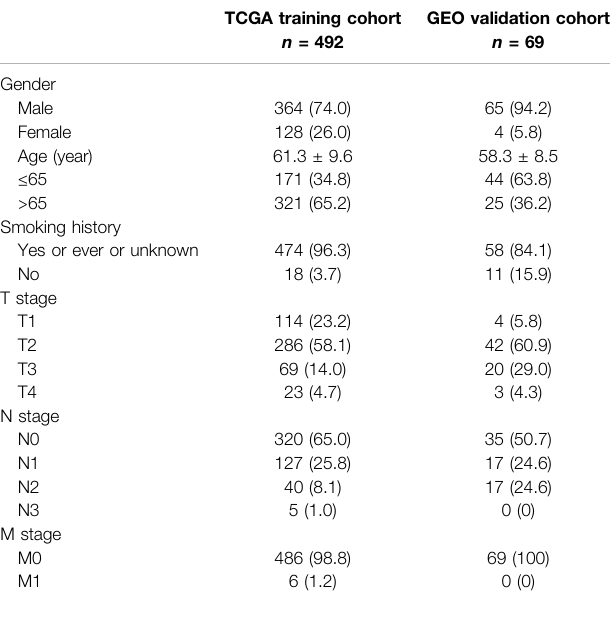
TABLE 1 | Patients ’